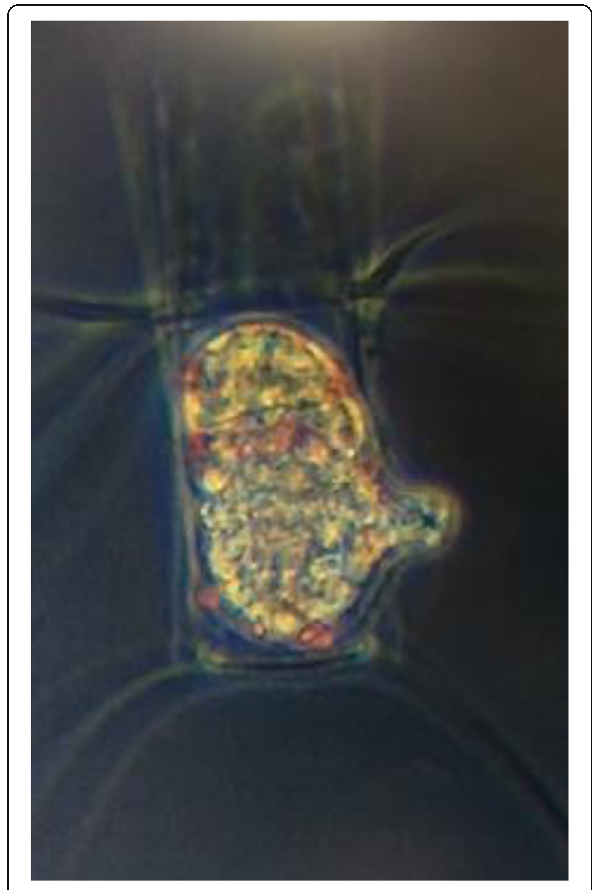
Fig. 2 Micrograph of Chaetocerous sp. parasitized by an endobiotic holocarpic member of